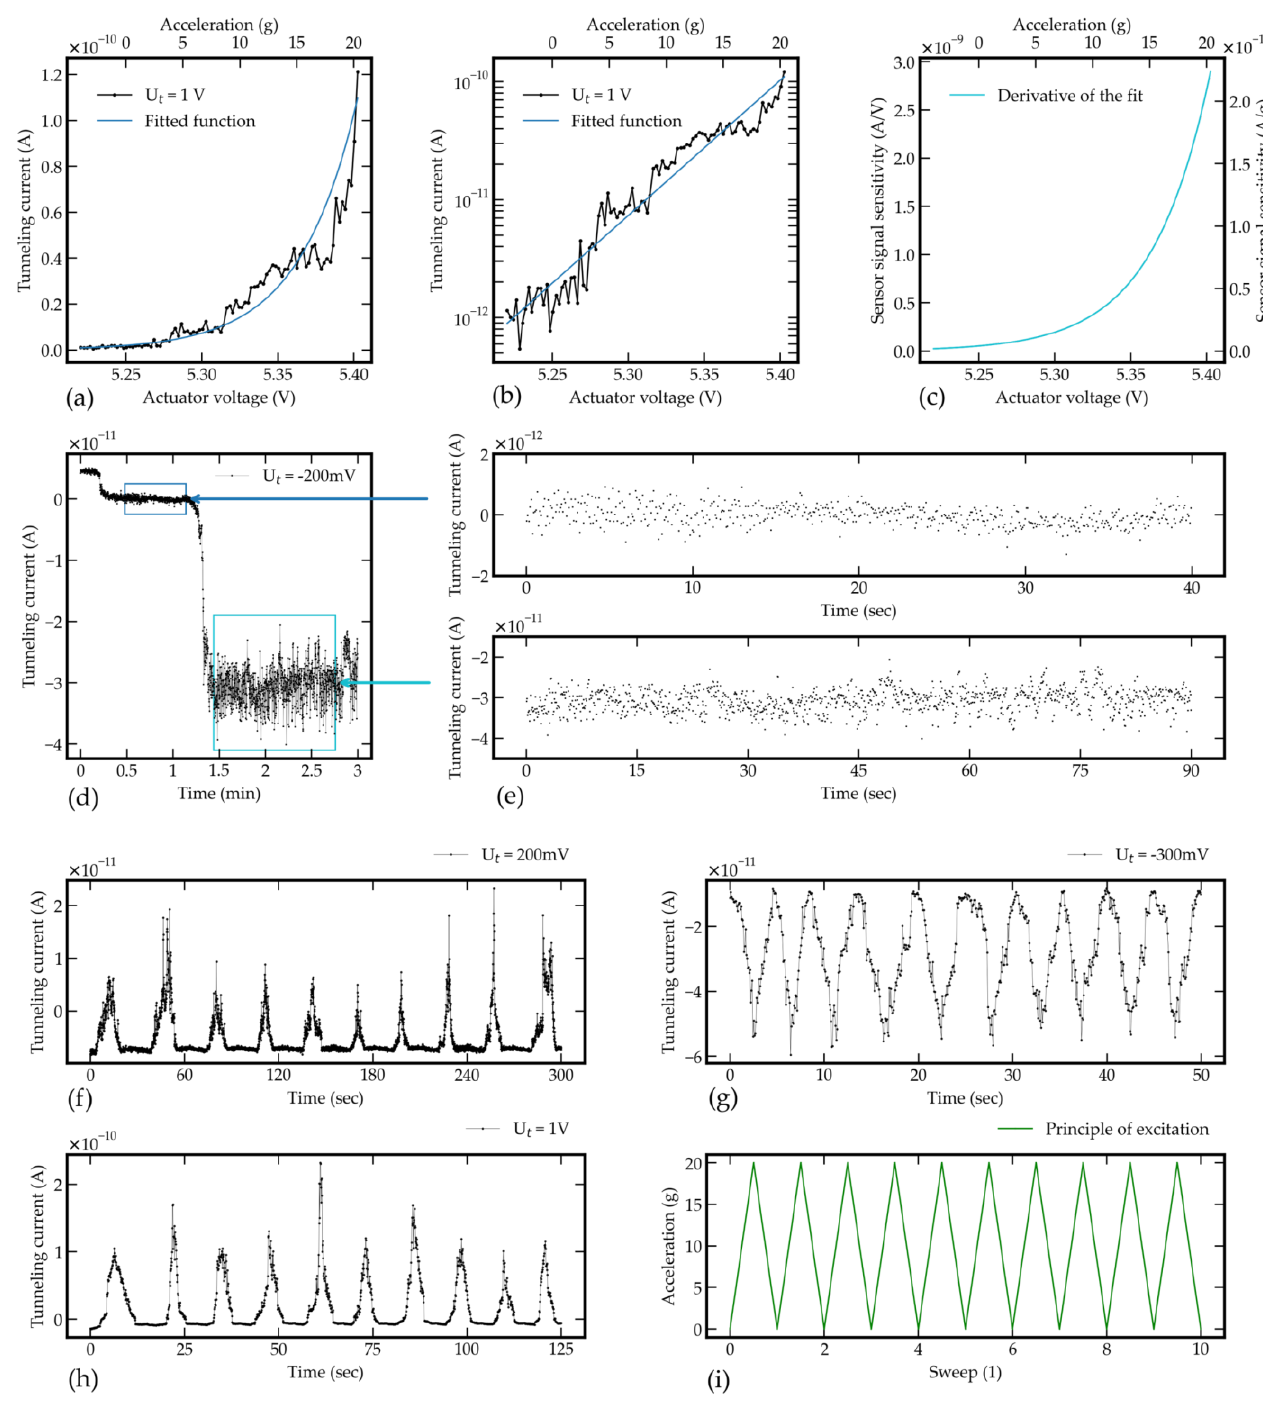
Figure 11. Measurements of tunneling current. ( a , b ) The tunneling effect verification on the sensor structure. ( c ) The fitted function of the sensor sensitivity. ( d ) Behavior under static load of an equivalent acceleration of 20 g. ( e ) Difference in signal noise depending on tunneling distance. ( f – h ) Response of the tunneling sensor by ramp excitation by electrostatic self-test action for different tunneling bias voltage and initial tunneling tip distances. ( i ) Principle of multiple excitation.